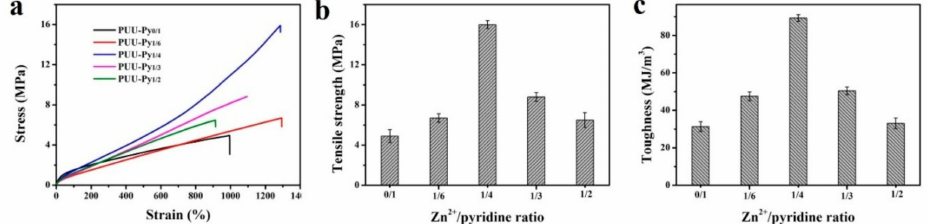
Figure 1. ( a ) Stress-strain curves of PUU-Py elastomers; comparison of ( b ) tensile strength and ( c ) toughness of PUU-Py with various Zn 2 + / pyridine